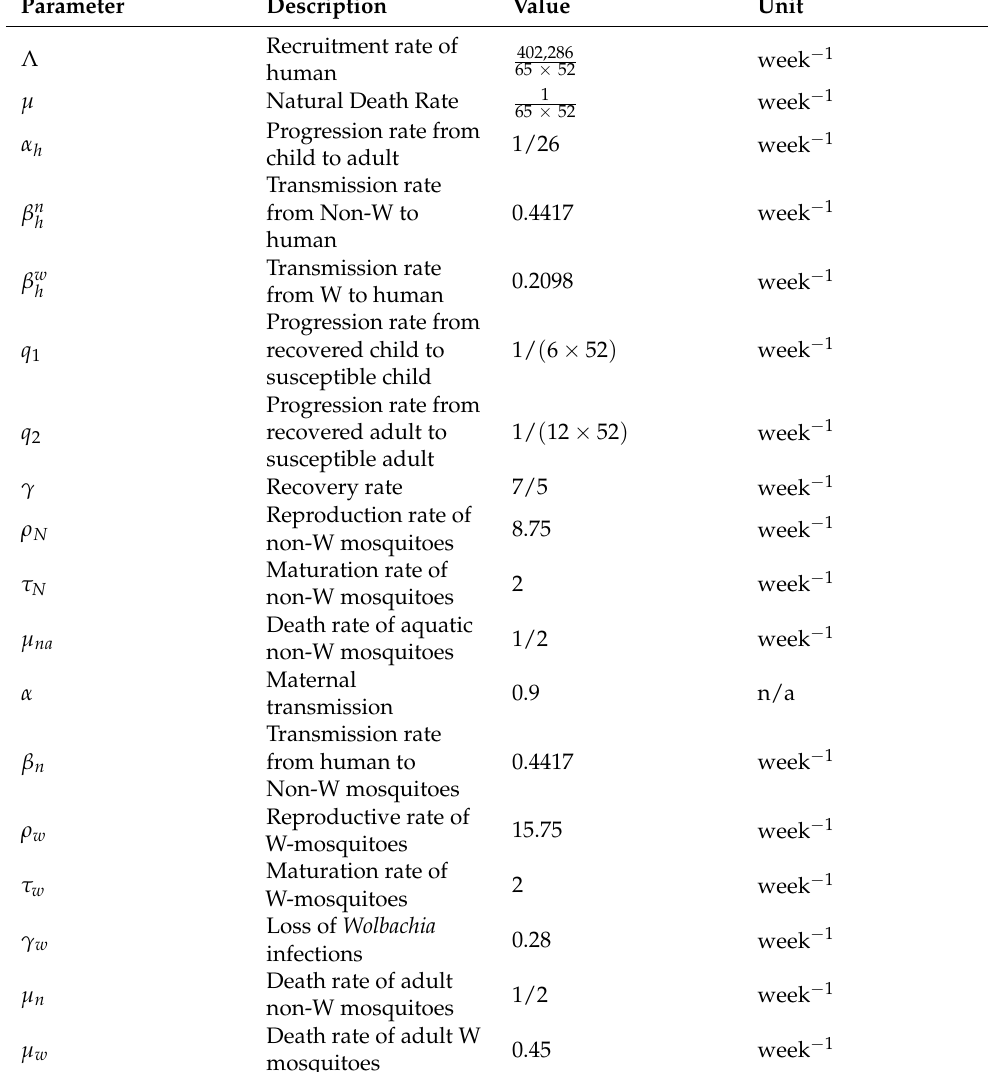
Table 1. Parameter values and